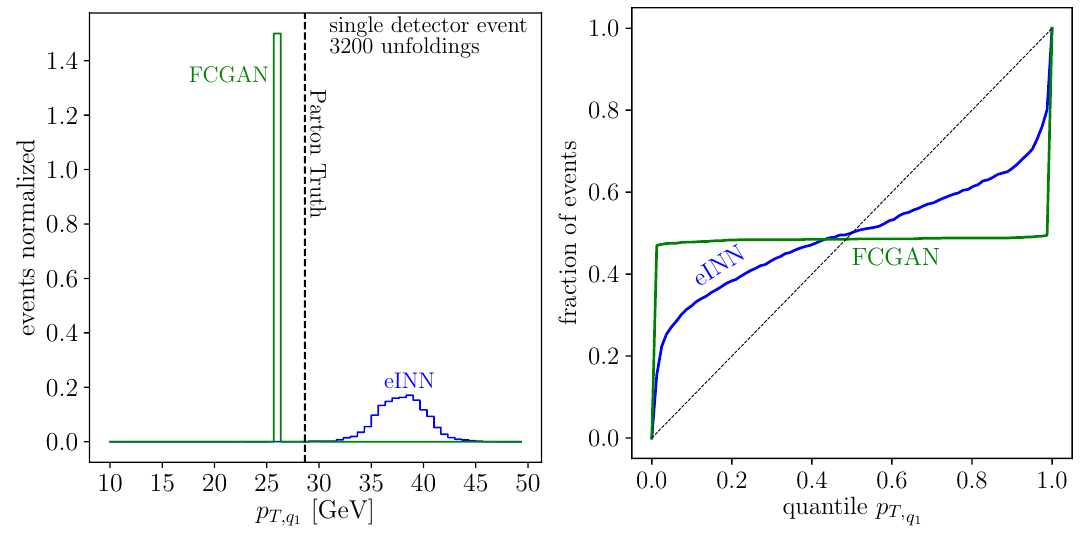
Figure 4: Left: illustration of the statistical interpretation of unfolded events for one event. Right: calibration curves for p extended